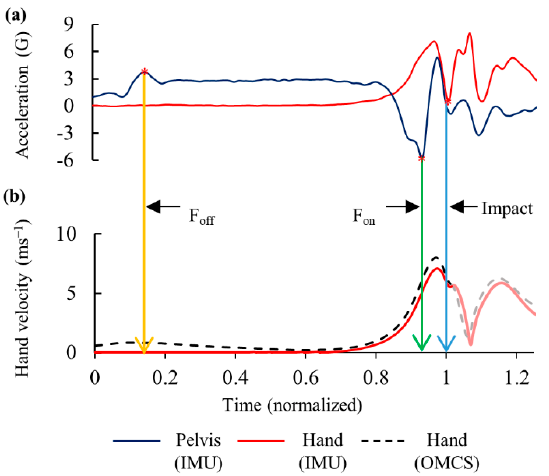
Figure 2. Typical graph of ( a ) Foot off (F off ), foot on (F on ) and impact events detected by inertial measurement units (IMUs) and ( b ) linear velocity of the hand determined by IMU and optical motion capture system (OMCS).